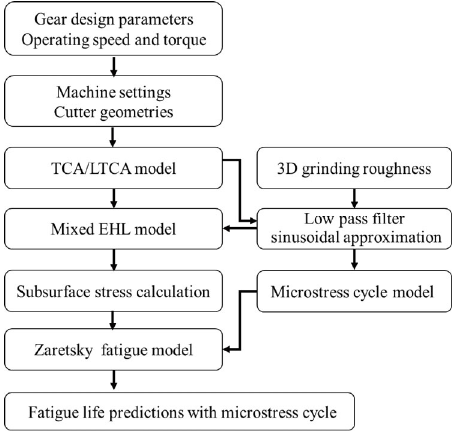
Fig. 10 Methodology of fatigue prediction with microstress